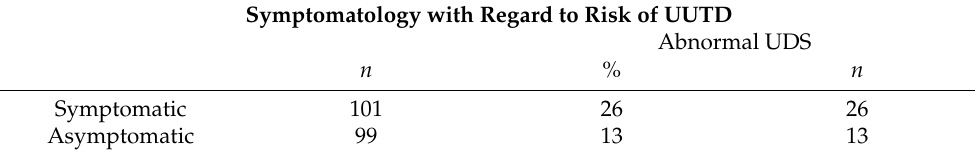
Table 3. The presence of LUTS and UDS findings indicative of NLUTD and potential UUTD. Symptomatology with Regard to NLUTD Abnormal UDS n % n Symptomatic 101 87 88 Asymptomatic 106 79 84 Symptomatology with Regard to Risk of UUTD Abnormal UDS n % n Symptomatic 101